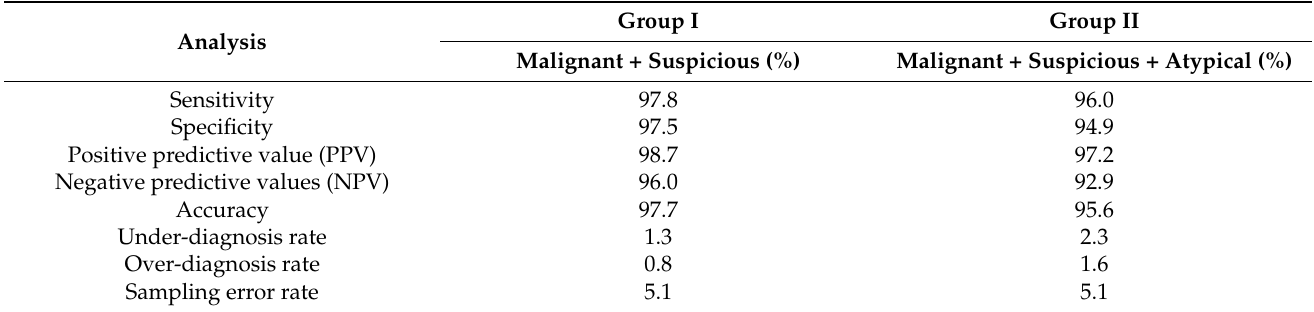
Table 7. Analysis of diagnostic accuracy of